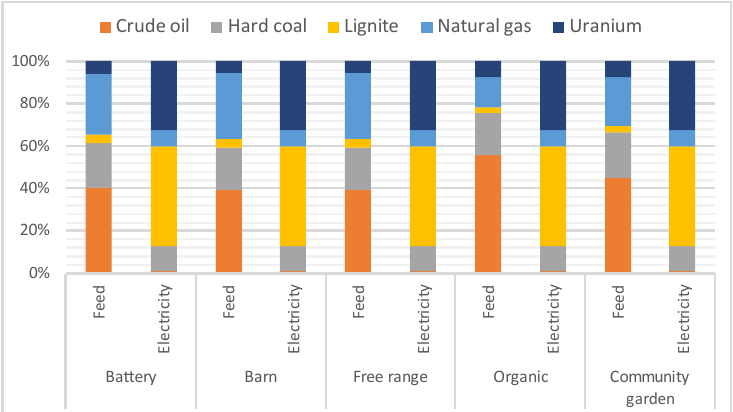
Figure 1. Relative contribution of non-renewable energy resources in feed and electricity production for each laying system for the production of one kilogram of eggs. Table 4. Energy use for the production of one kilogram of eggs per laying system.